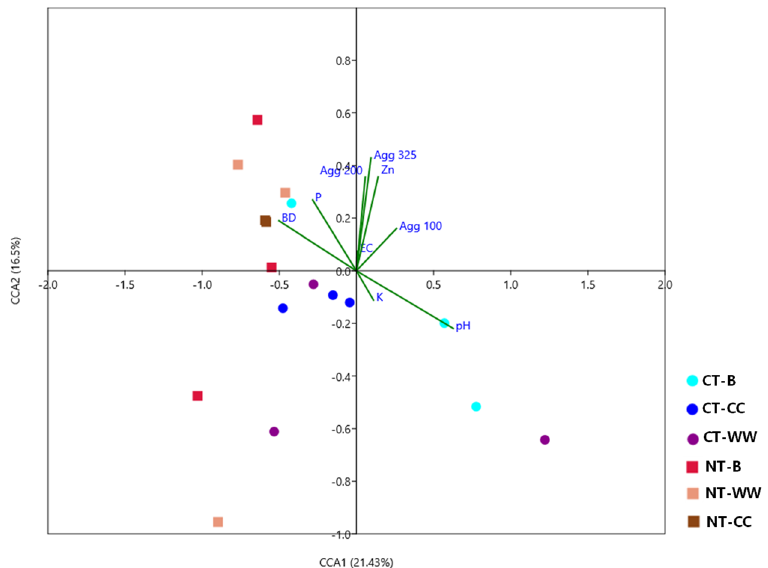
Figure 3. The distance based canonical correspondence analysis (CCA) illustrating the influence of soil properties on fungal communities (estimated using ASV’s). Soil properties are labelled in blue and treatments are in different colors. Lengths of each arrow/vector indicates the correlation. CT-B: Conventional Tillage-Bare fallow; CT-CC: Conventional Tillage-Cover Crop; CT-WW: Conventional Tillage-Winter Weeds; NT-B: No-tillage-Bare fallow; NT-CC: No-tillage-Cover Crop; NT-WW: No-tillage-Winter Weeds.